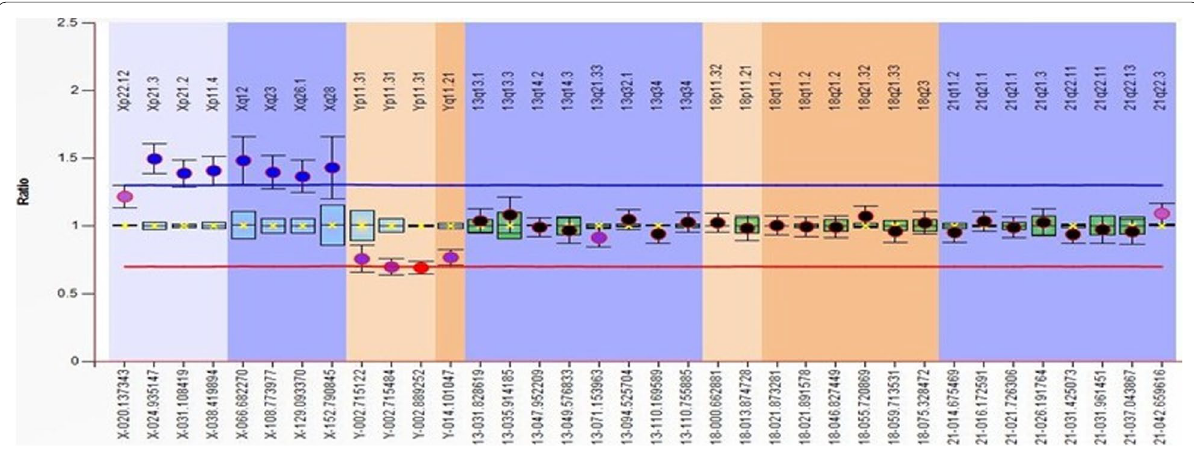
Fig. 5 Ratio charts of the MLPA results for the triploidy sample. The MLPA probe ratio showed duplication of ~1.36 for X probes and ~0.73 for Y probes, detecting signals for the Y chromosome and indicating the XXY